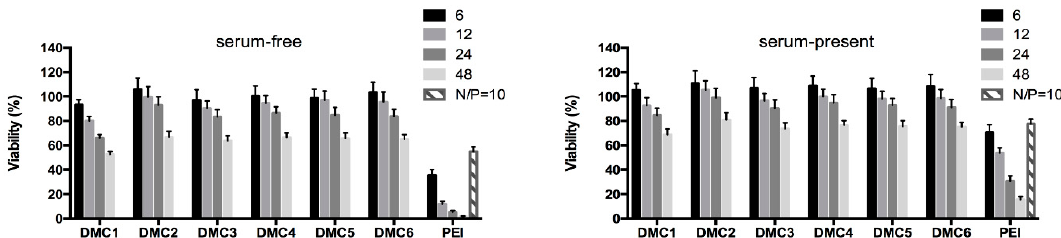
Figure 4. Cell viabilities of COS-7 cells exposed to polyplexes at different polymer/DNA mass ratios for 1h and incubated for 2 days, as determined via MTT assays under 0% serum conditions ( left ) and 10% serum conditions ( right ). Branched PEI (25 kDa) is included as a reference.